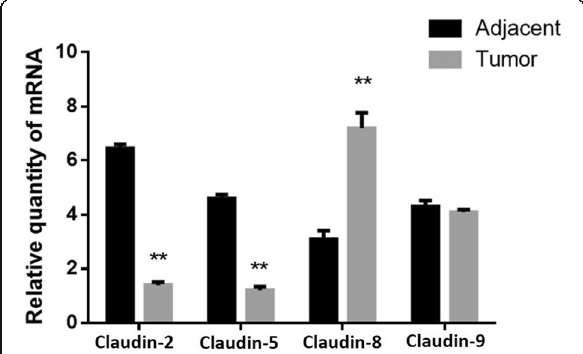
Fig. 3 mRNA expression levels of claudins in human nasopharyngeal carcinoma and non-neoplastic mucosae. Real-time PCR analysis of claudin expression in 12 human nasopharyngeal carcinoma tissues and non-neoplastic mucosae. * P < 0.05 and ** P < 0.01 compared with non-neoplastic